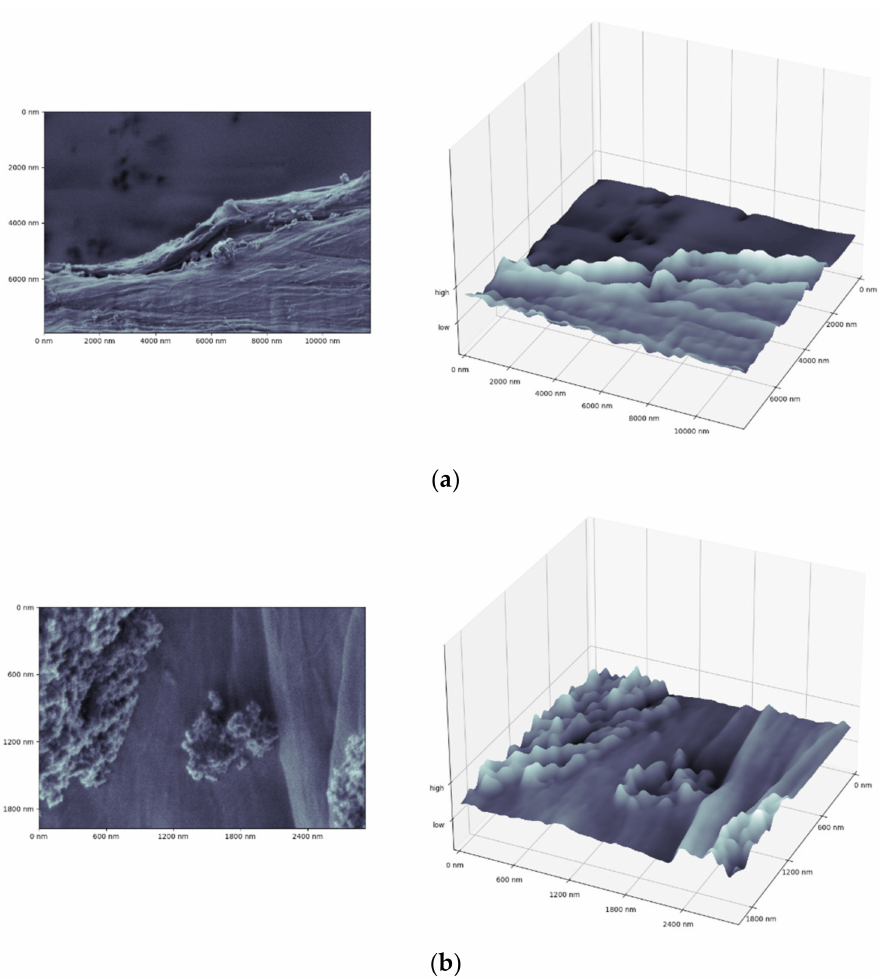
Figure 10. The 3D reconstruction of ( a ) the rough rubbish bag surface with ( b ) adsorbed elements (specimen from the fish’s